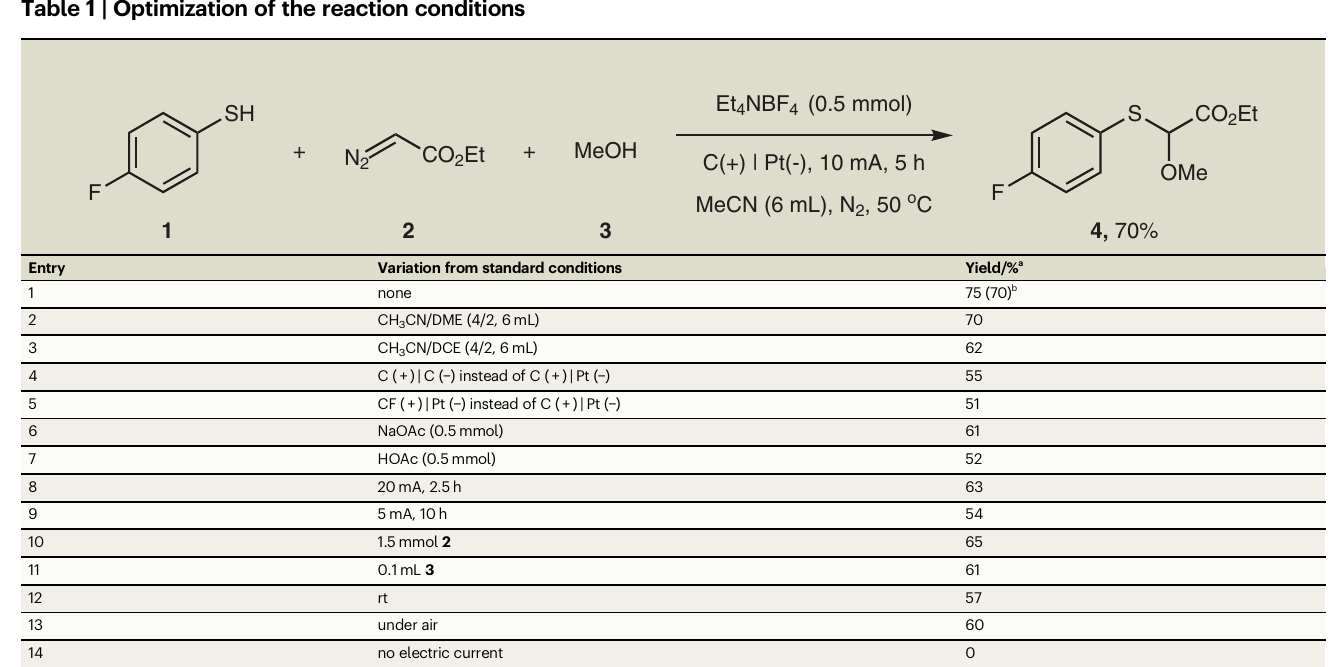
Table 1 | Optimization of the reaction